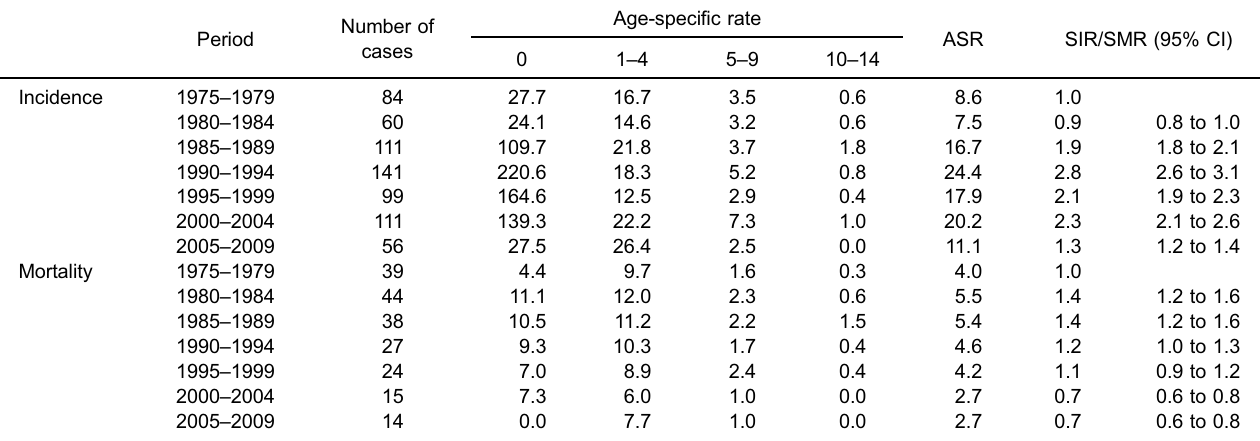
Table 1. Number of patients and annual rate per million children of neuroblastoma for both sexes in Osaka, 1975 – 2009